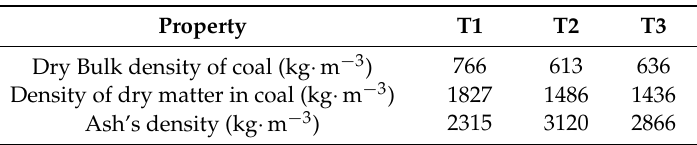
Table 2. Density of lignite samples and their ash.